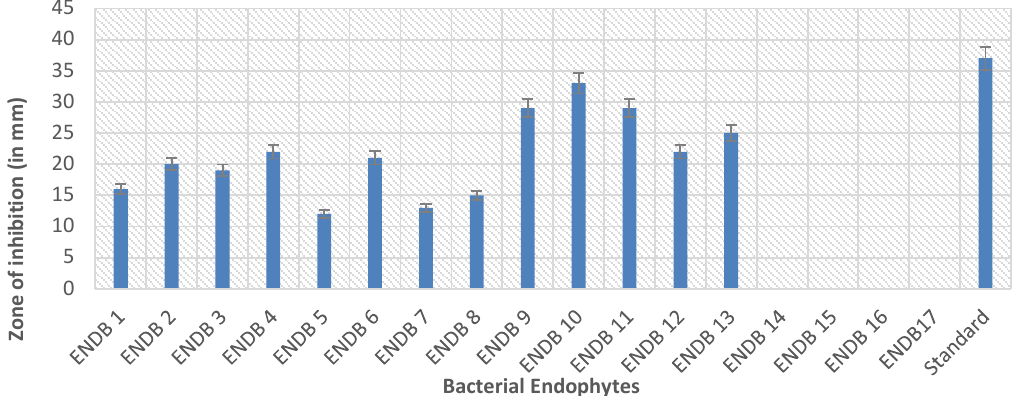
Figure 4. Antimicrobial potentiality spectra of bacterial endophytes against A. niger